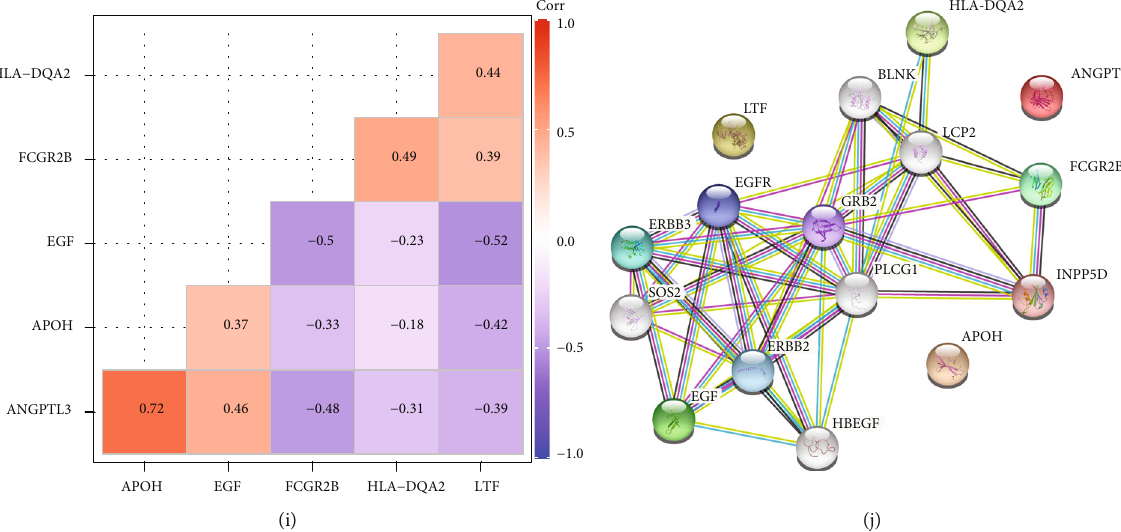
Figure 3: Identi fi cation and evaluation of IF/TA diagnostic genes. (a and b) The LASSO regression with 10-fold cross-validation of LTF , FCGR2B , HLA-DQA2 , EGF , ANGPTL3 , and APOH . (c) The AUC of diagnostic model in the training set. (d) The AUC of diagnostic model in the validation set. (e) The AUCs of all 6 diagnostic genes in the GSE76882 dataset. (f) The AUCs of all 6 diagnostic genes in the GSE120495 dataset. (g and h) The expression patterns of 6 diagnostic genes from the GSE76882 and GSE120495 datasets. ∗ in the fi gure is a signi fi cance marker, ∗ stands for P < 0 : 05 , ∗∗ stands for P < 0 : 01 , ∗∗∗ stands for P < 0 : 001 , and ∗∗∗∗ stands for P < 0 : 0001 . (i) Correlations between six key genes. The greater the correlation, the deeper the color (red is positive correlation and blue is negative correlation). (j) Protein interaction network of six